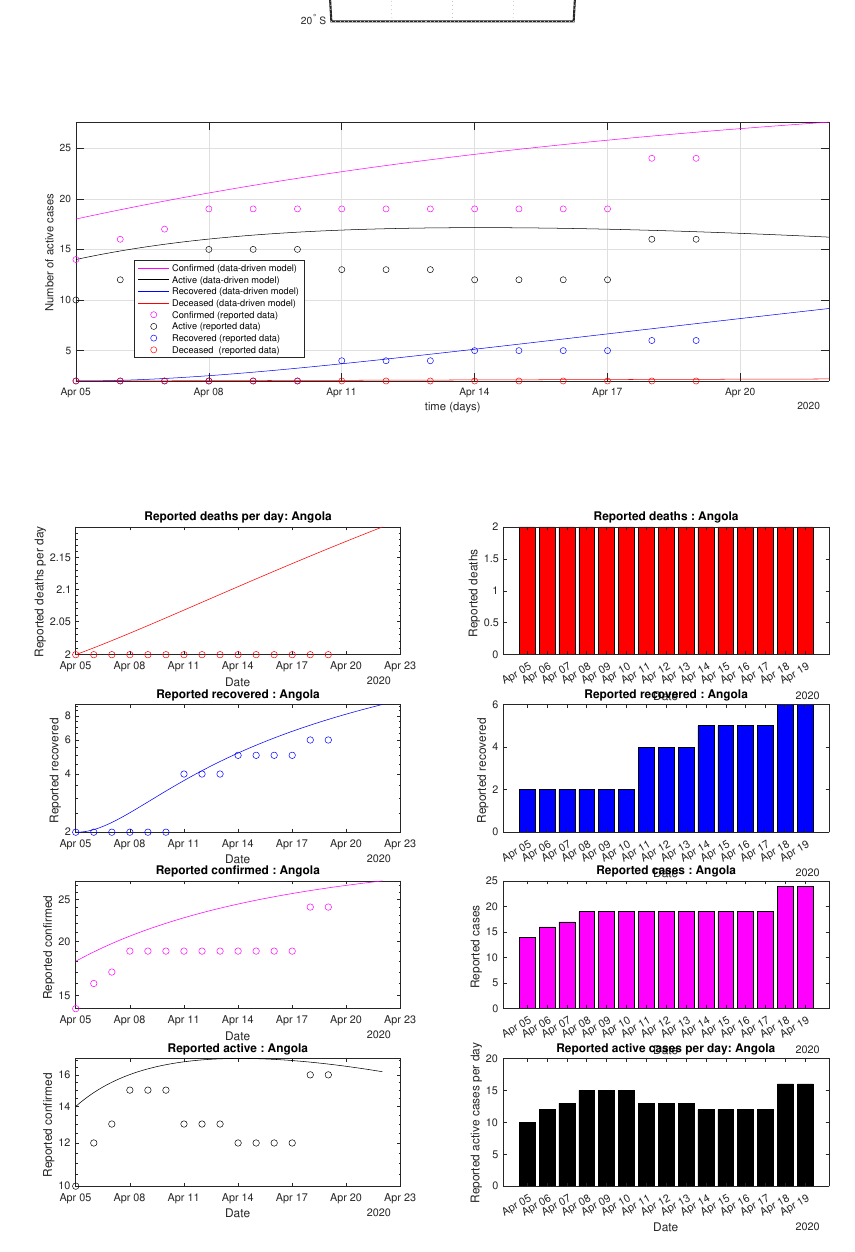
Figure 51. Angola: data of active, recovered, deceased (in circle or bar) vs. model of active, recovered, deceased over time. Tracking the number of active cases. Predictive analytics for the next couple